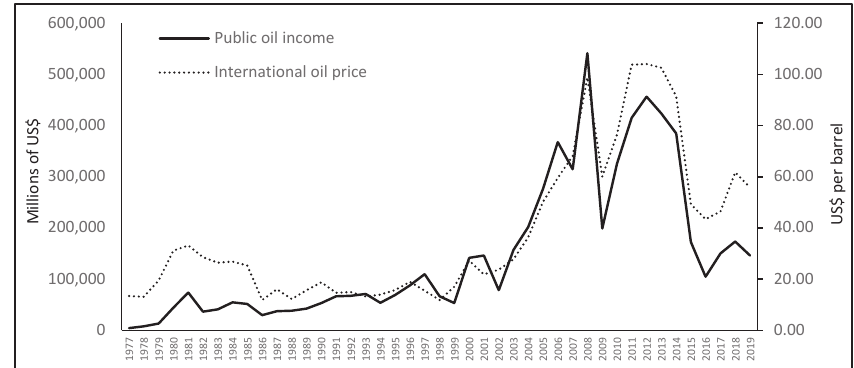
Figure 1. Public oil income